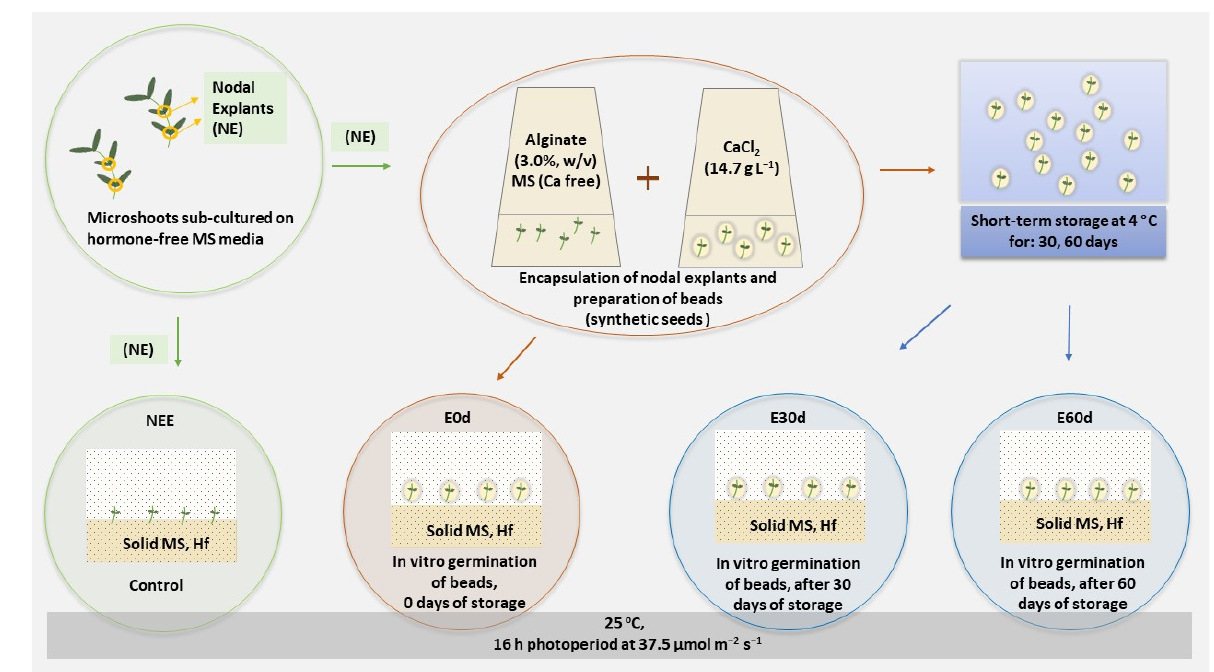
Figure 1. Schematic representation of C. candidissimum in vitro encapsulation of nodal explants and procedure starting from micro-shoots sub-cultured on hormone-free Murashige and Skoog (MS, Hf) medium. NEE: Non-encapsulated explants (control); E0d: encapsulated node explants; E30d: encap- sulated node explants stored at 4 °C, in the dark, for 30 days; E60d: encapsulated node explants stored at 4 °C, in the dark, for 60 days.